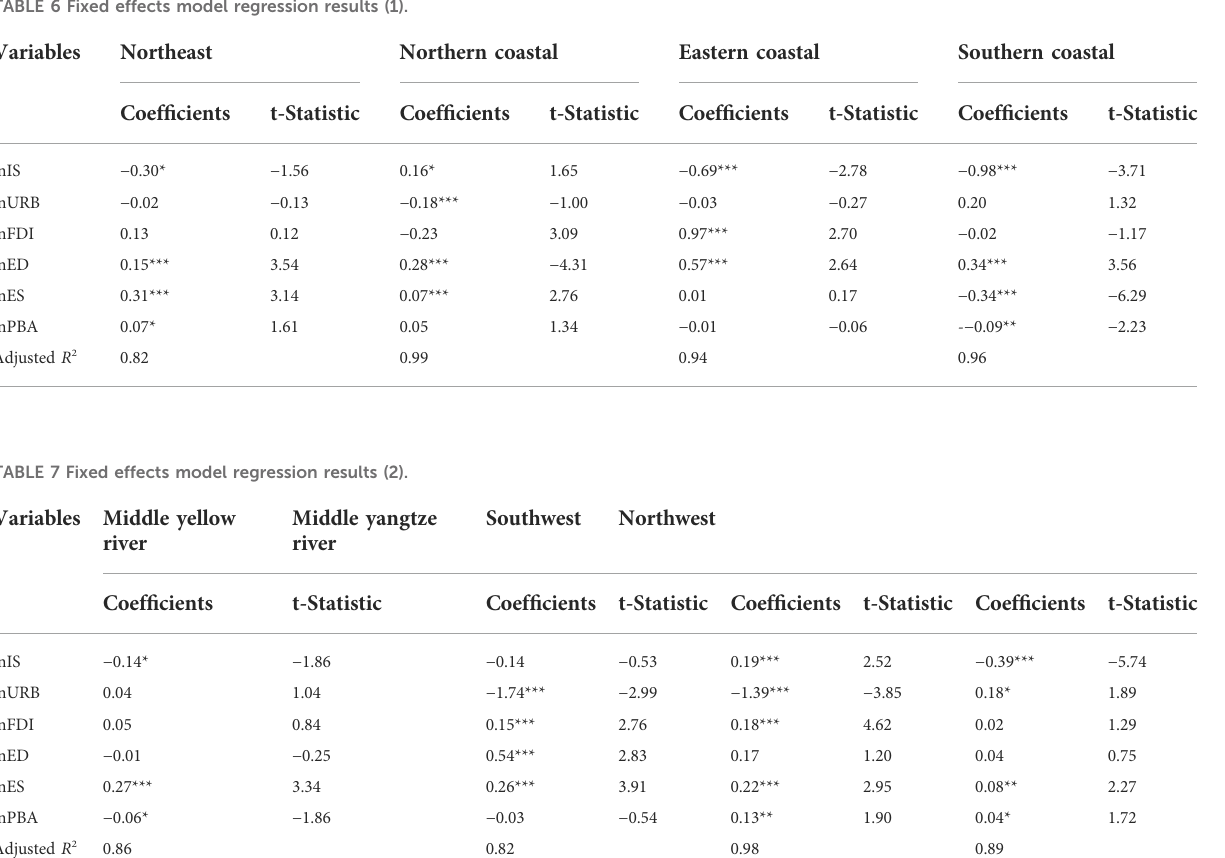
FIGURE 2 Dynamic average growth rate in the PBCEE of the eight economic regions.